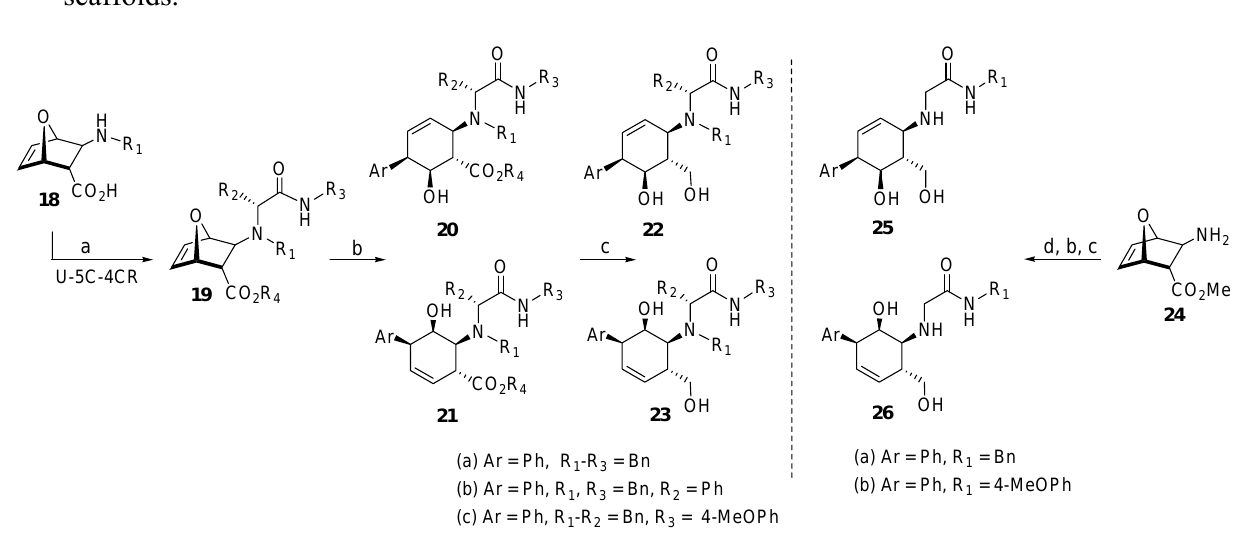
Figure 7. Design of Bcl-xL antagonists through structural modification of oxabicyclic